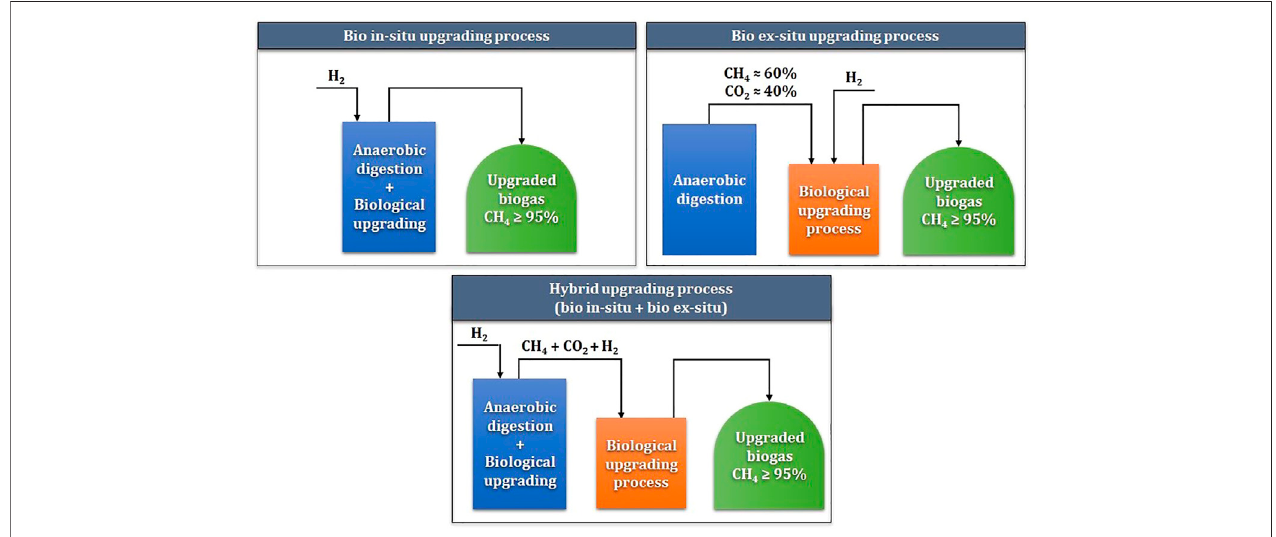
FIGURE 2 | Conceptual diagram of in-situ , ex-situ , and hybrid biological hydrogen methanation processes.